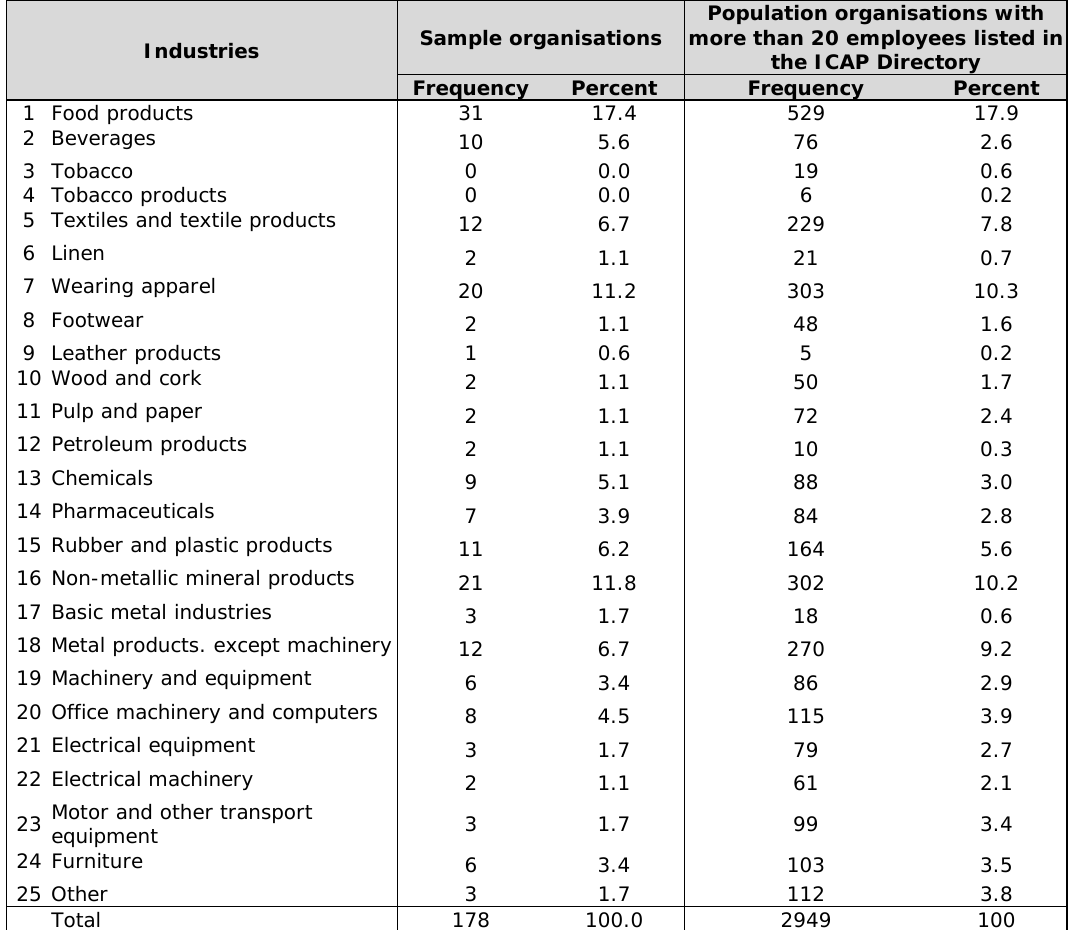
Table 1. “Main activities of the organisations in sample and